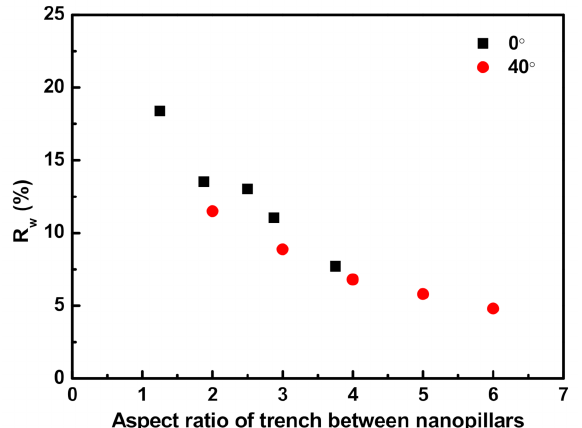
Figure 8. Weighted mean reflectance of Si substrates periodically arrayed with nanopillars at 0 ◦ and 40 ◦ as a function of the aspect ratios of trenches between the